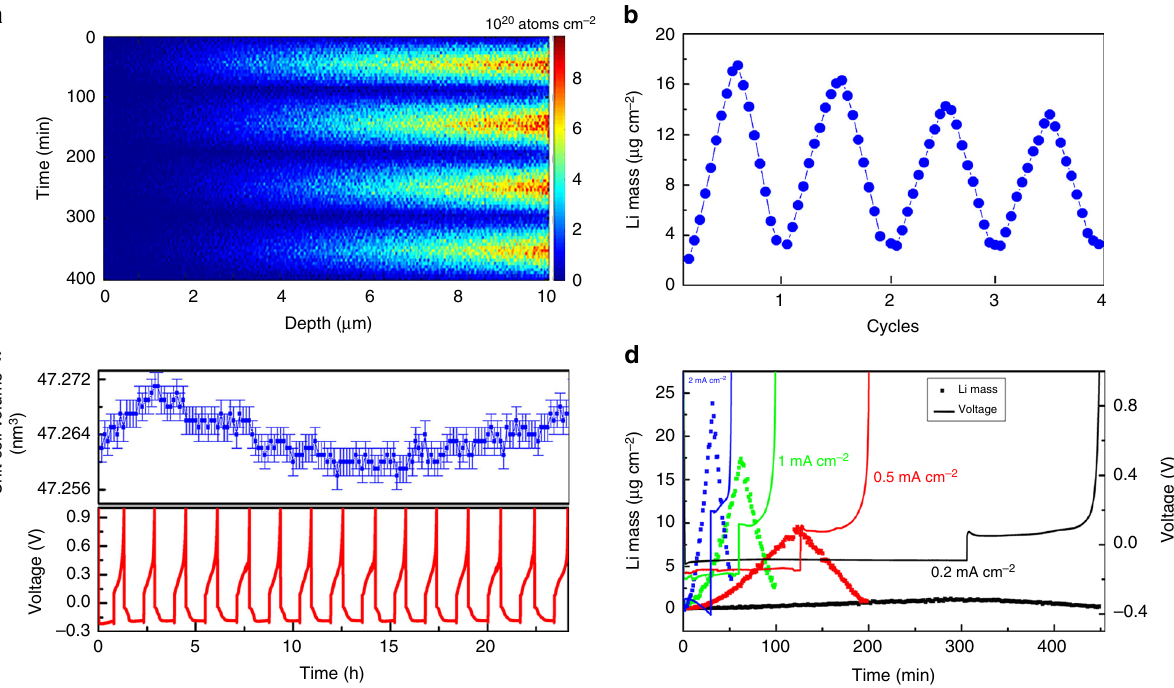
Fig. 7 Monitoring Li in the Cu current collector during plating and stripping. a Operando NDP during four plating and stripping cycles, focusing on the 10 μ m thick Cu current collector region from 0 to 10 μ m of the measurement shown in Fig. 1b. The depth is measured starting from the interface of the of the Cu current collector with the ambient atmosphere (as indicated by Fig. 1a,b), hence the Li-metal is plated on right side in the Figure. b Total amount of Li per cm 2 in the Cu current collector during the four plating/stripping cycles. c Cu lattice parameter from operando XRD during 15 cycles at 1.0 mA cm – 2 . The variation is the consequence of the daily temperature changes in the lab, indicating a 4 °C temperature difference during day and night. d Total amount of Li per cm 2 during the fi rst plating/stripping cycle at different current rates, quantifying the amount of Li incorporation in Cu depending on the